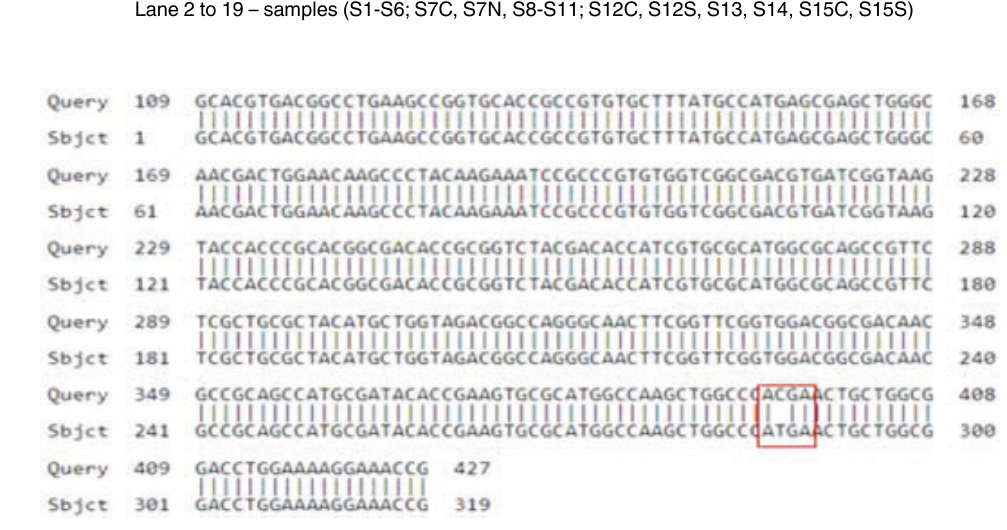
V Fig. 2 Sequence comparison of gyrA gene of isolate with reference strain J .